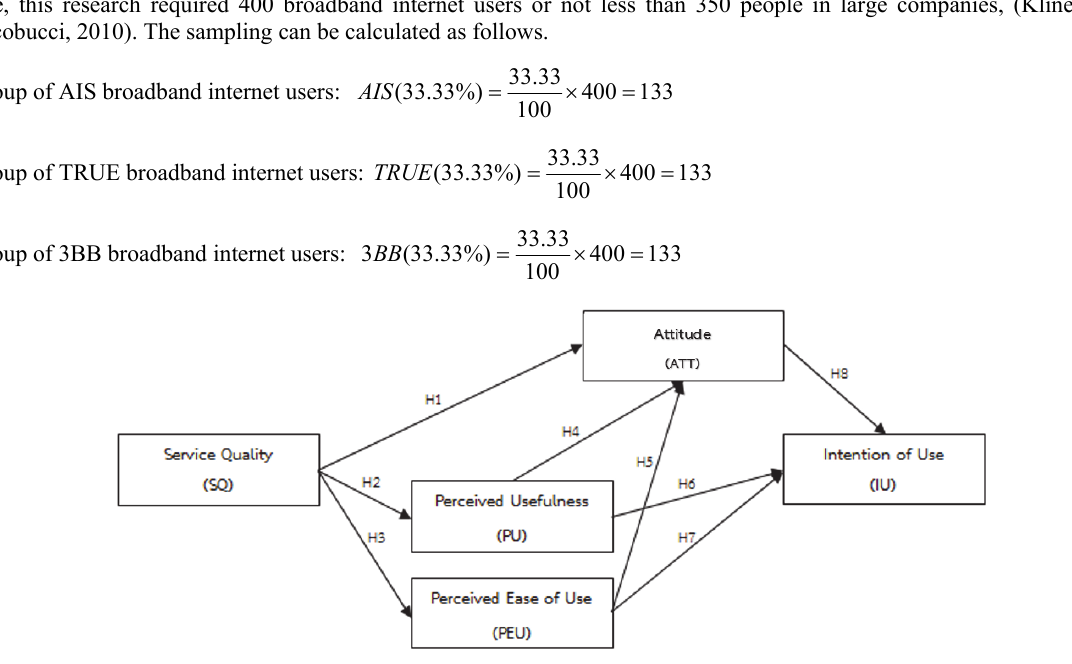
Fig. 1. Conceptual method